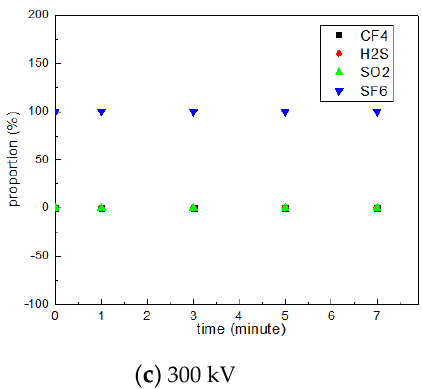
Figure 6. Gas composition results under different voltages.